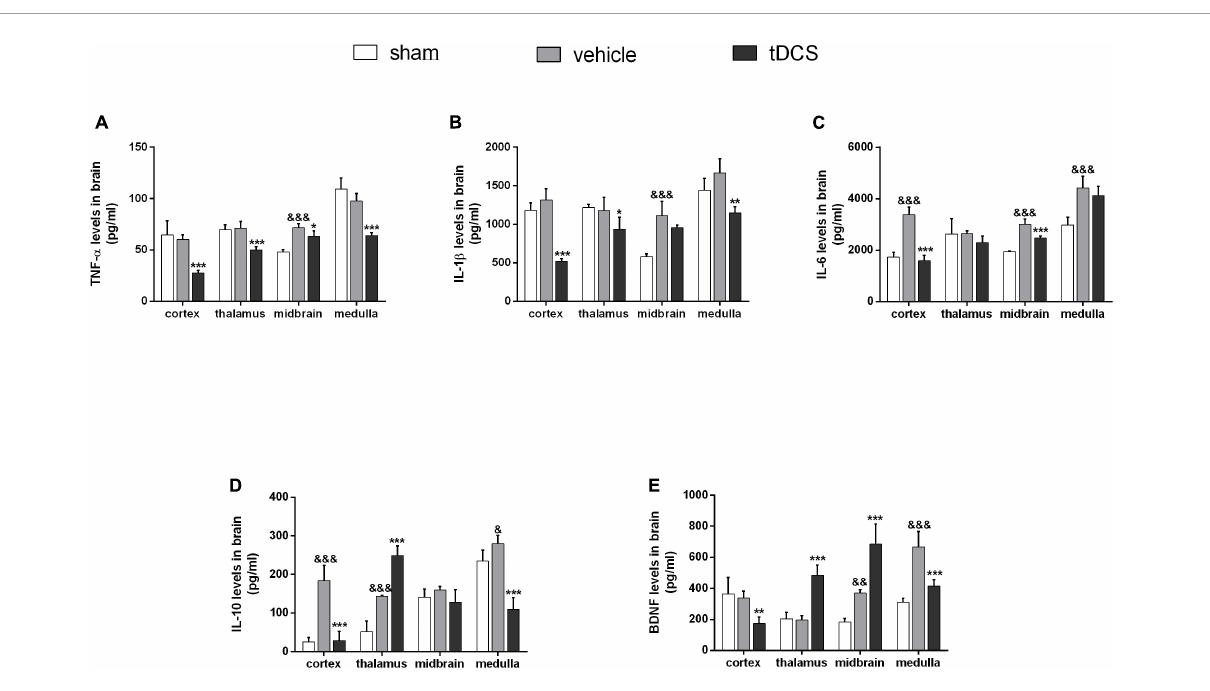
FIGURE3 Effect of tDCS on the contents of inflammatory cytokines in cortex, thalamus, midbrain, and medulla of rats with SCI. Statistical analysis results of (A) TNF-a, (B) IL-ß, (C) IL-6, (D) IL-10, and (E) BDNF for three groups in cortex, thalamus, midbrain, and medulla of rats with SCI. vehicle group vs. sham group, &&& p < 0.001, && p < 0.01, and & p < 0.05; tDCS group vs. vehicle group, *** p < 0.001, ** p < 0.01, and * p < 0.05, n =